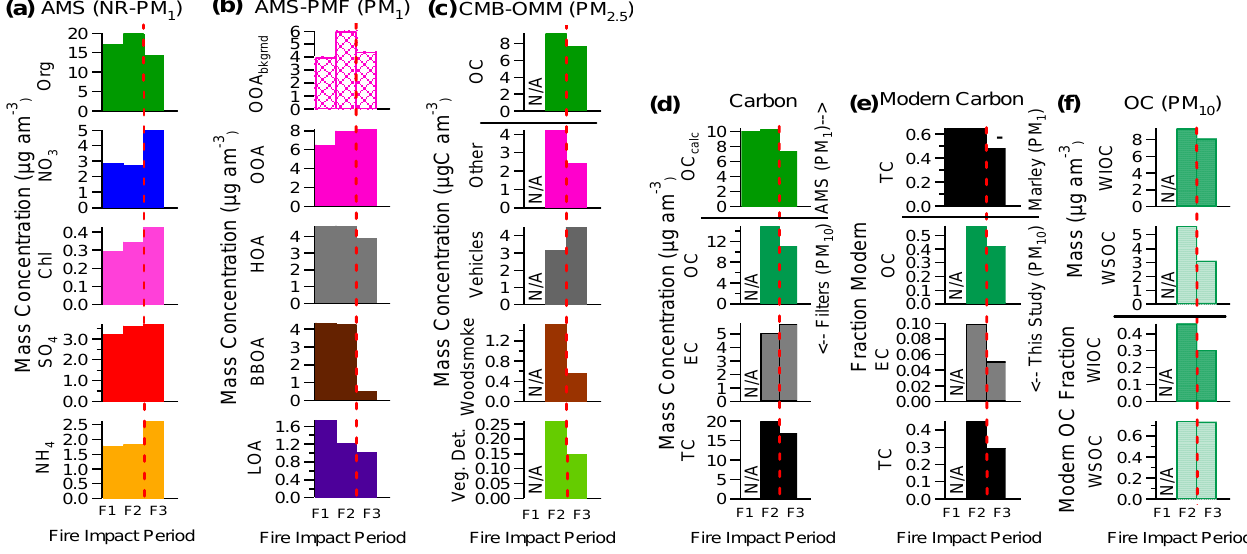
Figure 10. Fire period analysis graphs, comparing the average values of different parameters for the high fire (F1, F2) and low fire (F3) periods, for (a) AMS species, (b) AMS-PMF factors, (c) CMB-OMM total and factors, (d) carbon mass estimated from the AMS and measured from the 14 C filters from this study; (e) fraction of modern carbon for the different datasets, and (f) mass and fraction of modern carbon for the WSOC and WIOC fractions from this study. (Legend: - = less than 30% time series, N/A = no data)